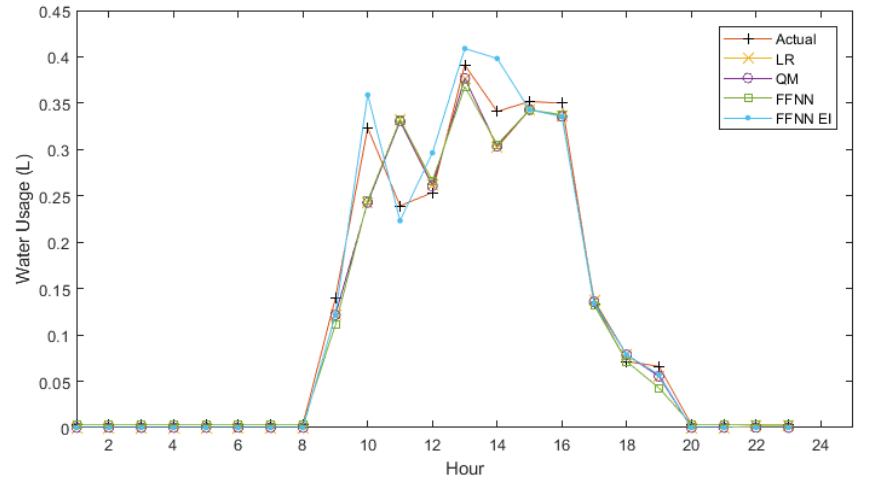
Figure 6. Day-ahead forecasts for peppers.